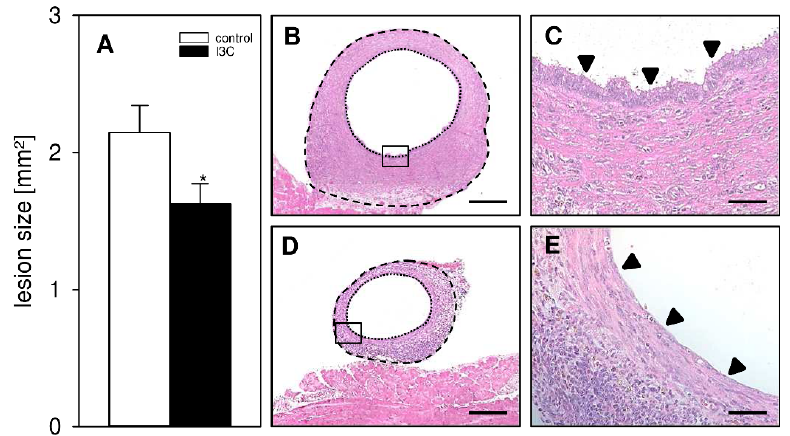
Figure 3. ( A ): Caliper-assessed lesion size (mm 2 ) of endometriotic lesions in vehicle-treated control (white bar; n = 8) and I3C-treated BALB/c mice (black bar; n = 8). Mean ± SEM; * p < 0.05 vs. control. ( B - E ): HE-stained sections of endometriotic lesions (borders marked by broken lines, cyst-like dilated endometrial glands marked by dotted lines) 28 days after transplantation of uterine tissue samples to the abdominal wall of a vehicle-treated control ( B , D ) and an I3C-treated BALB/c mouse ( C , E ). ( D ) and ( E ) shows higher magnification of insert in ( B ) and ( C ). Scale bars: ( B , C ) = 200 µm; ( D , E ) = 50 µm.